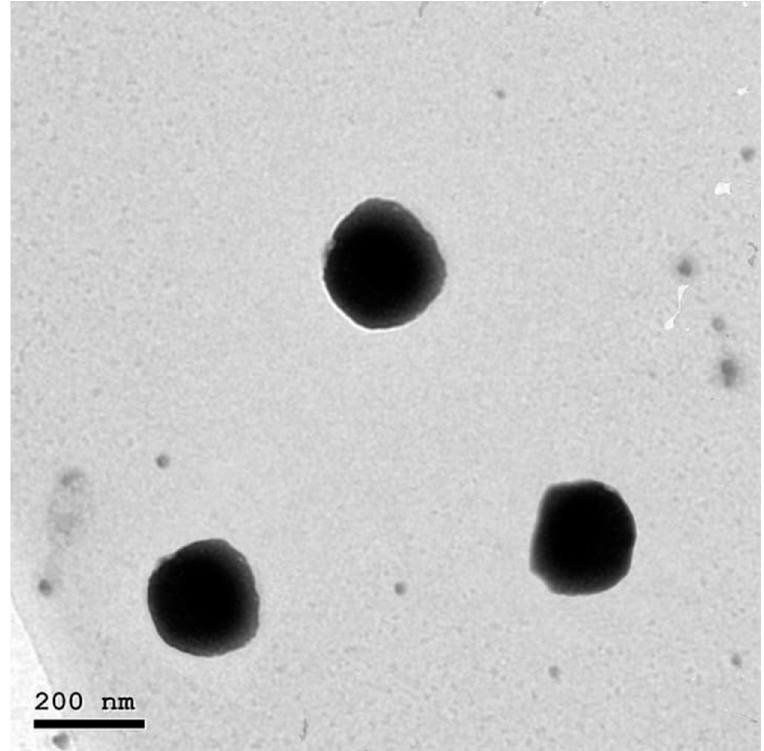
Figure 3. Transmission electron photomicrograph of the optimum NFD-CTS-PLGA nanocomposites.